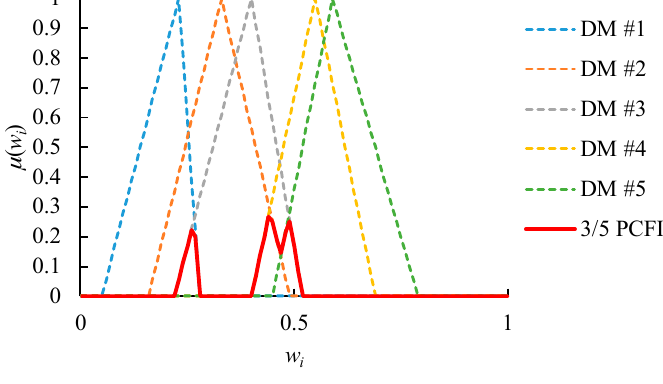
Figure 5. The 3 / 5 PCFI Figure 5. The 3/5 PCFI result.